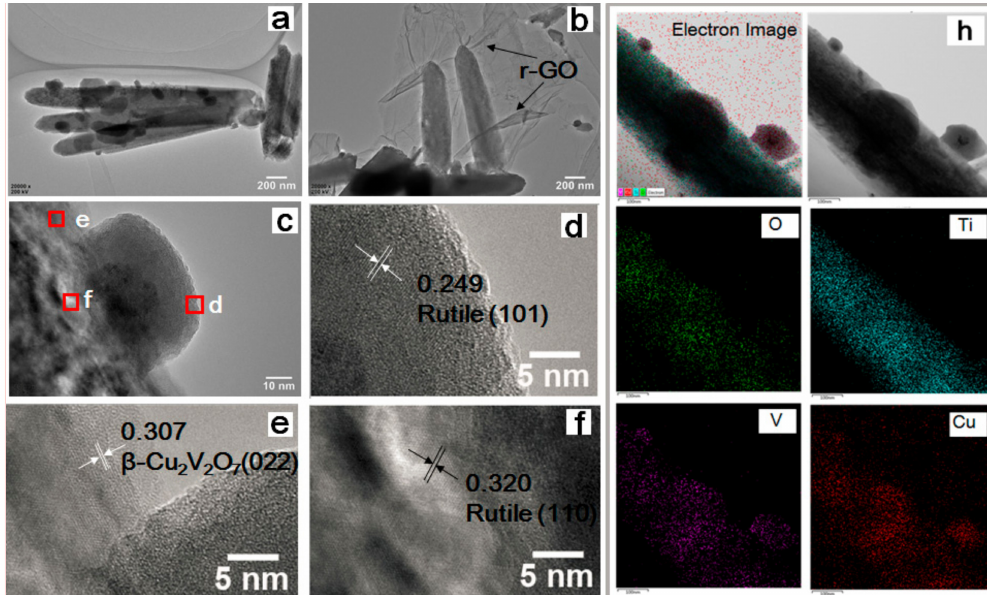
Figure 3. Transmission Electron Microscopy (TEM) images of β -Cu 2 V 2 O 7 /TiO 2 ( a ); and r-GO/ β -Cu 2 V 2 O 7 /TiO 2 ( b ); High Resolution Transmission Electron Microscopy (HR-TEM) images of GO/ β -Cu 2 V 2 O 7 /TiO 2 ( c – f ); morphology and energy dispersive X-ray (EDX) elemental mapping of r-GO/ β -Cu 2 V 2 O 7 /TiO 2 NRs sample ( h